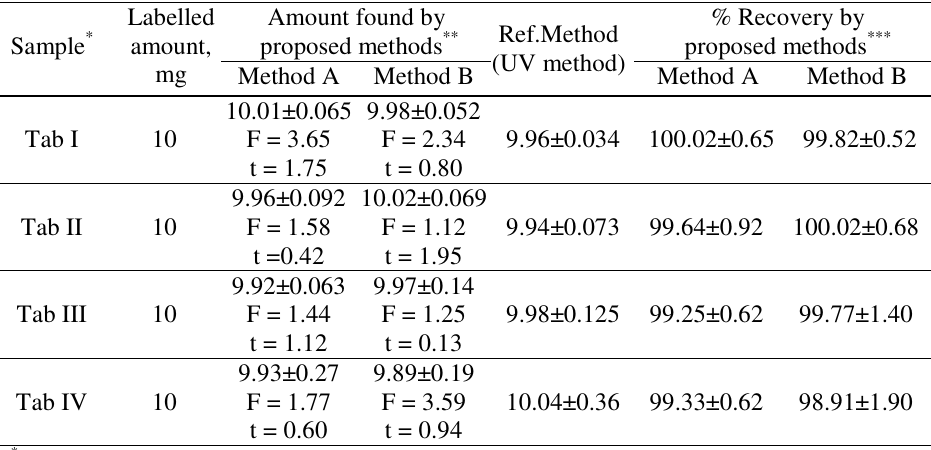
Table 2. Determination of ezetimibe in pharmaceutical